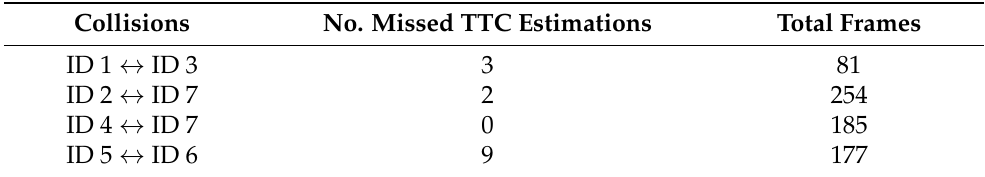
Table 3. Number of missed TTC estimations for each collision between two objects together with total number of frames before a collision happens in a